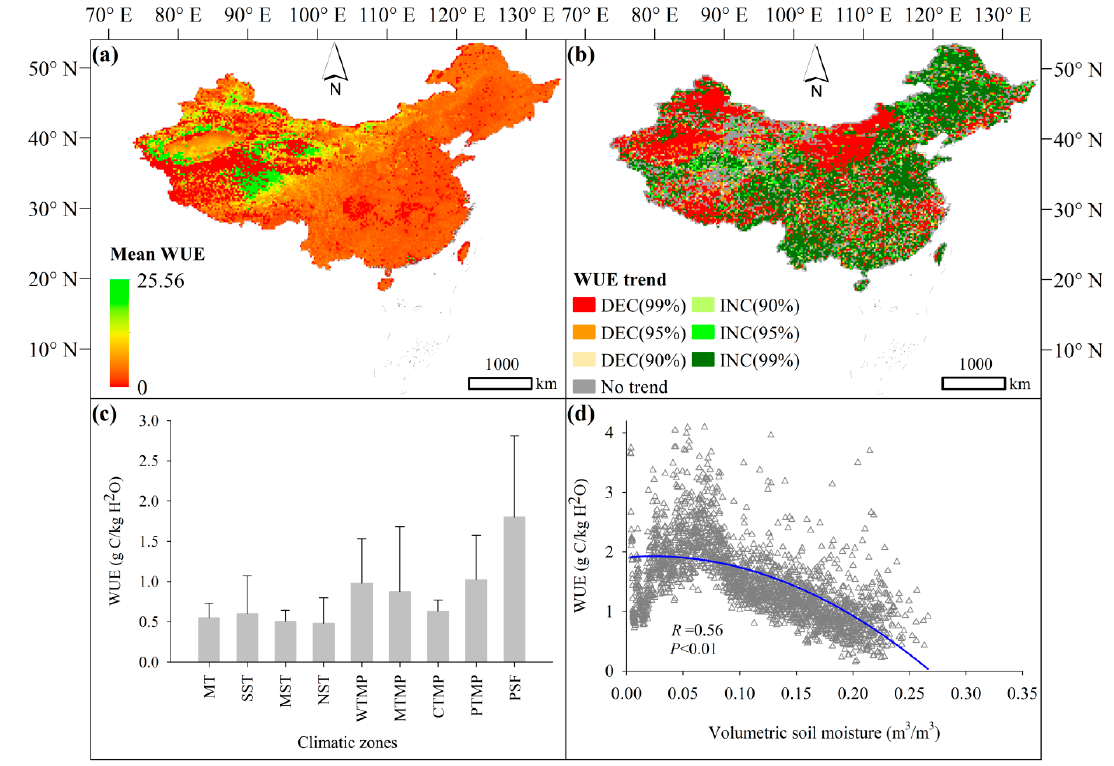
Figure 3. Temporal and spatial variation characteristics of water use efficiency ( WUE ) in the terrestrial ecosystems of China during the growing season from 1985 to 2014. ( a ) Multi-year average WUE in the growing season; ( b ) Mann–Kendall test of the WUE change trend (“DEC” is the decrease trend and “INC” is the increase trend) in the growing season; ( c )multi-year average WUE inthe growing season in different climatic zones, whiskers indicate standard deviation; ( d )scatter plot between WUE and SM in the growing season, and the blue solid line is the change trend of fitted by quadratic curve. The abbreviations of MT, SST, MST, NST,WTMP, MTMP, CTMP, PTMP, and PSF represent the marginal tropical zone, south subtropics zone, middle subtropics zone, north subtropics zone, warm temperate zone, middle temperate zone, cold temperate zone, temperate zone in Qinghai–Tibet Plateau, and the sub-frigid zone in Qinghai–Tibet Plateau(PSF), respectively.